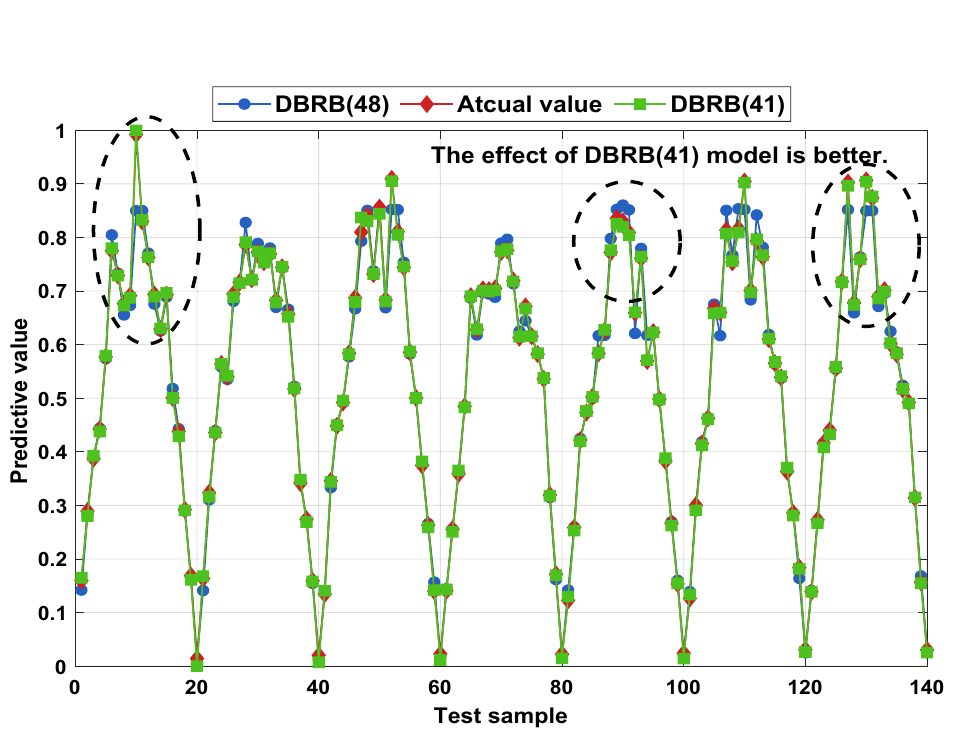
Figure 22. Comparison of DBRB(41) and